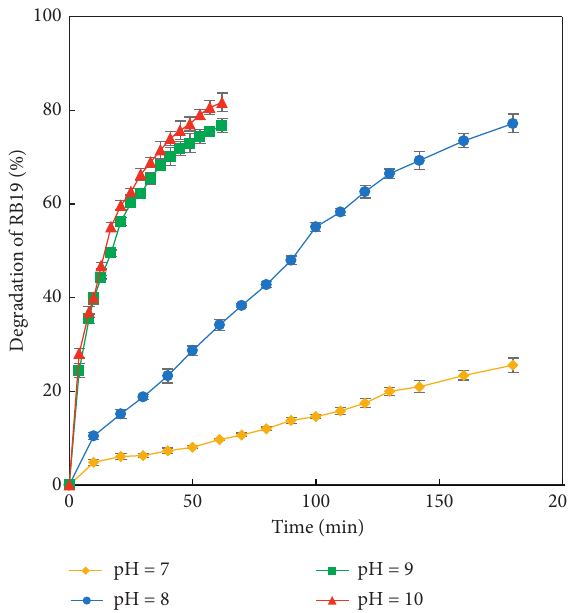
, 20mM H 2 O 2 , and 0.1mg/L 3